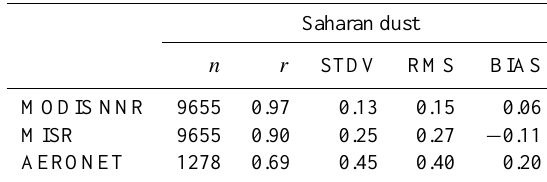
Table 1. Summary of AOD comparison results with MODIS NNR, MISR and AERONET ( n is the number of points; r is the correlation coefficient; RMS is the root mean square of the differences; STDV is the standard deviation of the differences, and BIAS is the mean difference of the log-transformed